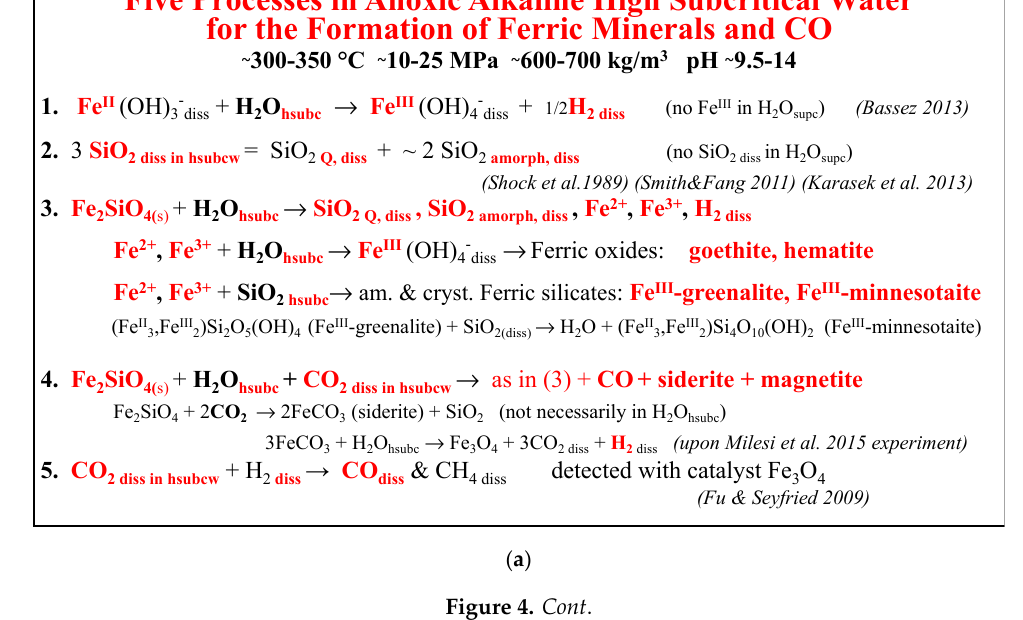
(Fu & Seyfried 2009)